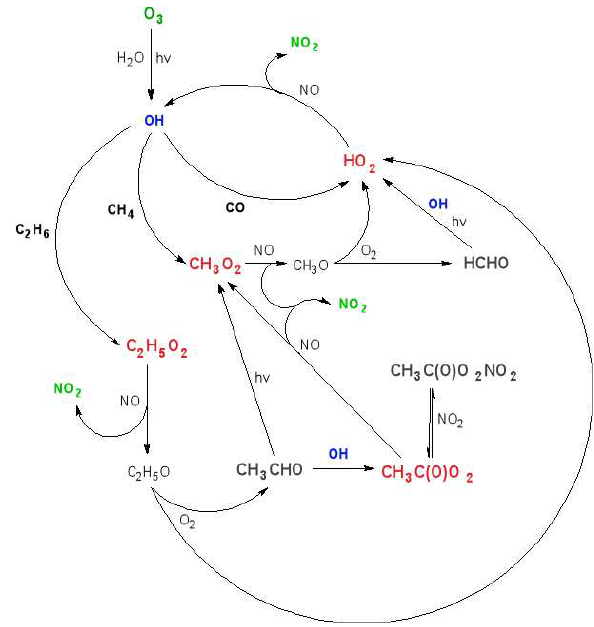
Fig. 1. CO, CH 4 and VOC (ethane shown as an example) chemistry Fig. 1. CO , CH 4 and VOC (ethane shown as an example) chemistry at high NO x . at high NO x 30